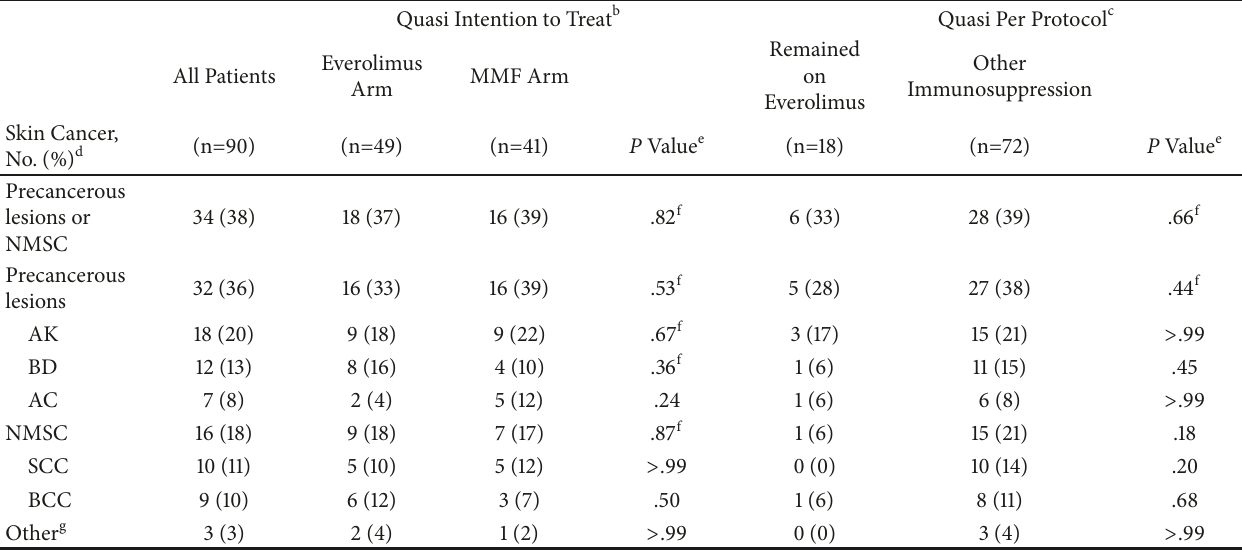
Table 3: Posttransplant skin cancer by treatment groups a